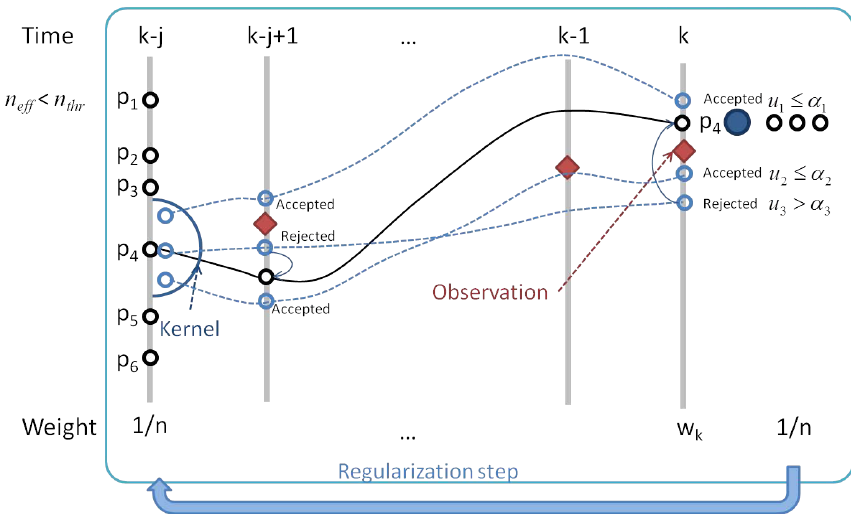
Fig. 3. Particle traces in the regularization step under the lagged filtering approach.